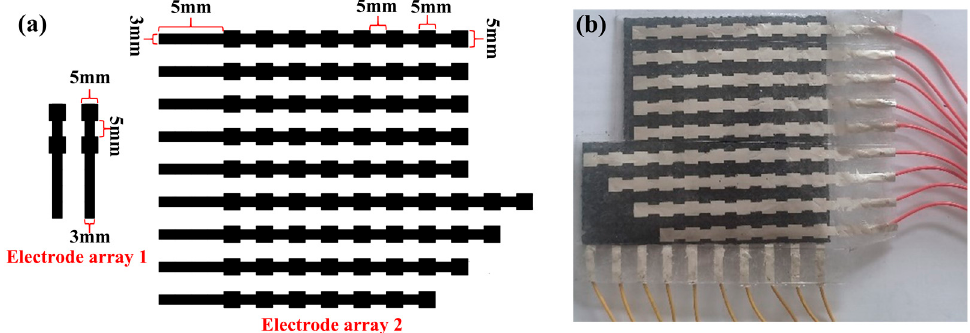
Figure 5. Fabrication of the sensor pressure array. ( a ) The electrode array pattern; ( b ) the actual image.